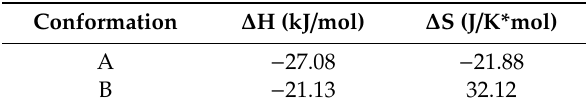
Table 3. Thermodynamic parameters associated with the complex formation of 1 with 6 in vacuum. Conformation A reflects binding of 1 guest to the dicarboxylatophenoxy moiety while conformation B reflects binding of the guest in the cavitand core